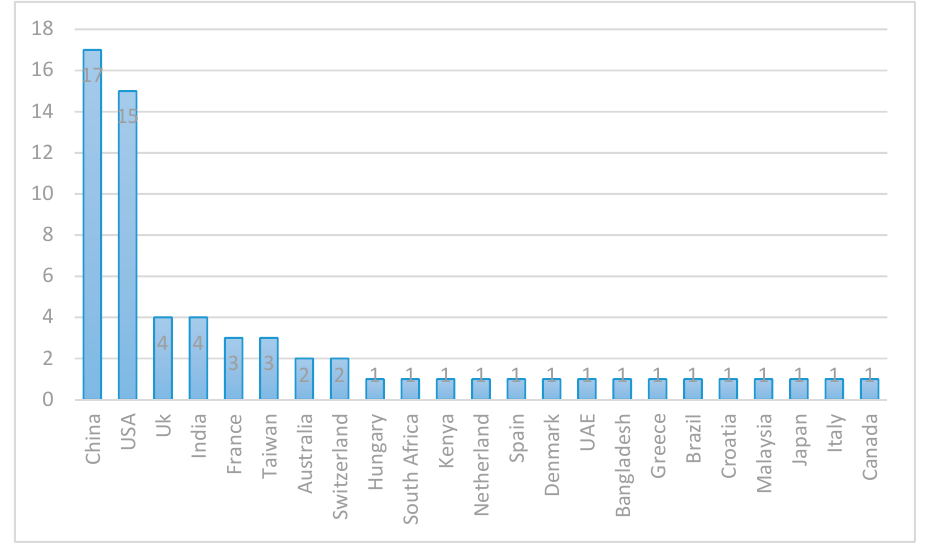
Figure 8. Distribution of the papers by the countries of the authors.